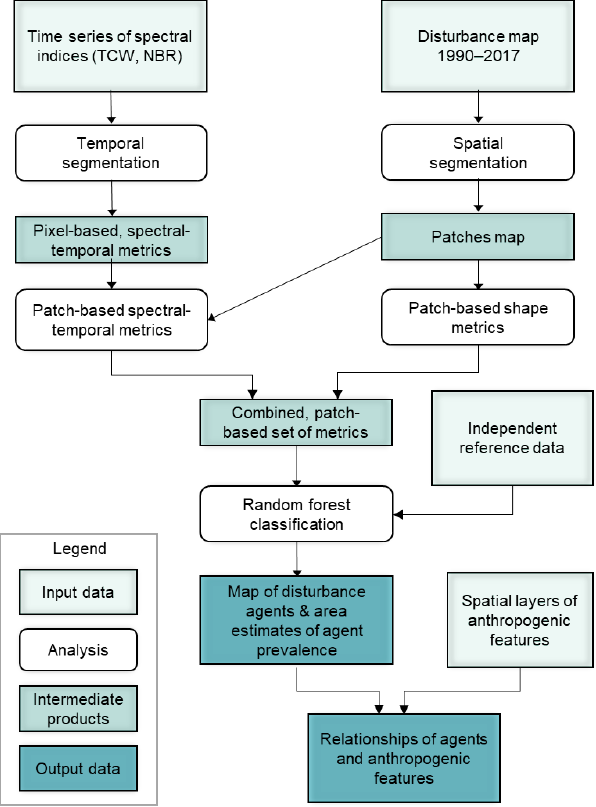
Figure 1. Overall workflow of the research methodology employed to identify and map disturbance agents in the Argentine Dry Chaco.